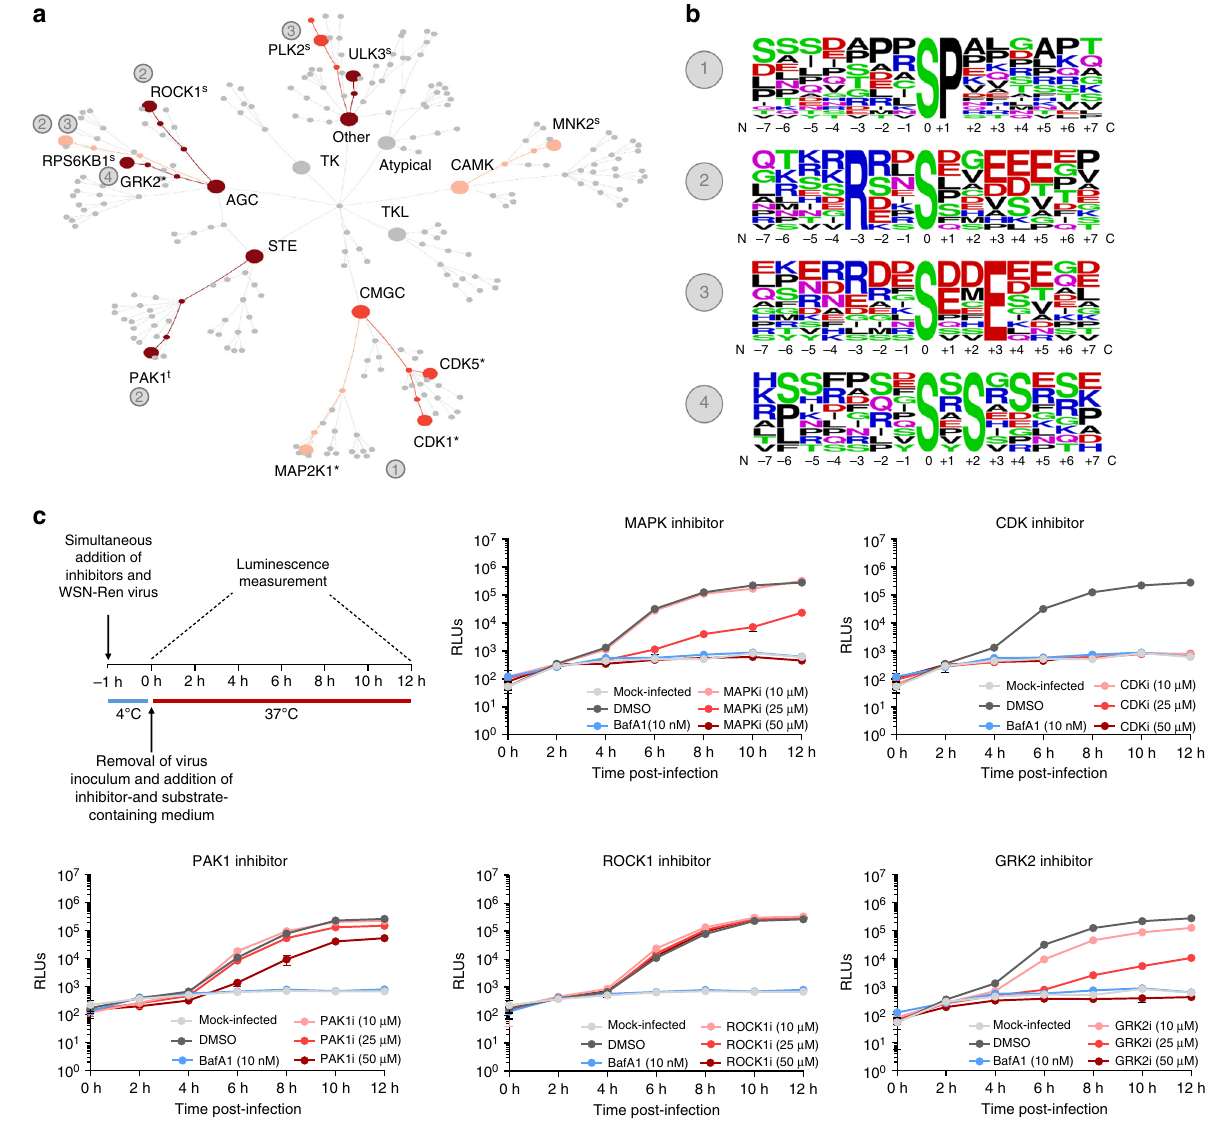
Fig. 2 Kinase activation pro fi ling reveals IAV-responsive kinases as potential drug targets. a Top kinases predicted to be involved in the differential phosphorylation of proteins at 5 and/or 15 min post IAV-infection are shown in color (light orange: predicted to be activated at 5 min p.i., red: predicted to be activated at 15 min p.i.; dark red: predicted to be activated at both time points) in the context of all cellular kinases (s signi fi cantly enriched hit, t trend towards signi fi cance, * top predicted kinase for which enrichment calculation is not possible, see Methods and Supplementary Fig. 3). b Over-represented sequences in IAV-responsive peptides are shown and linked with numbers to the kinases identi fi ed in ( a ). c Effect of inhibitors against the identi fi ed IAV- responsive kinases on the replication of a Renilla-encoding virus. The ef fi ciency of viral replication was determined by luminescence measurement (RLUs) in live cells every 2 h. The dotted line represents a 10-fold difference in viral replication with regard to DMSO-treated cells. Error bars represent standard deviation from three